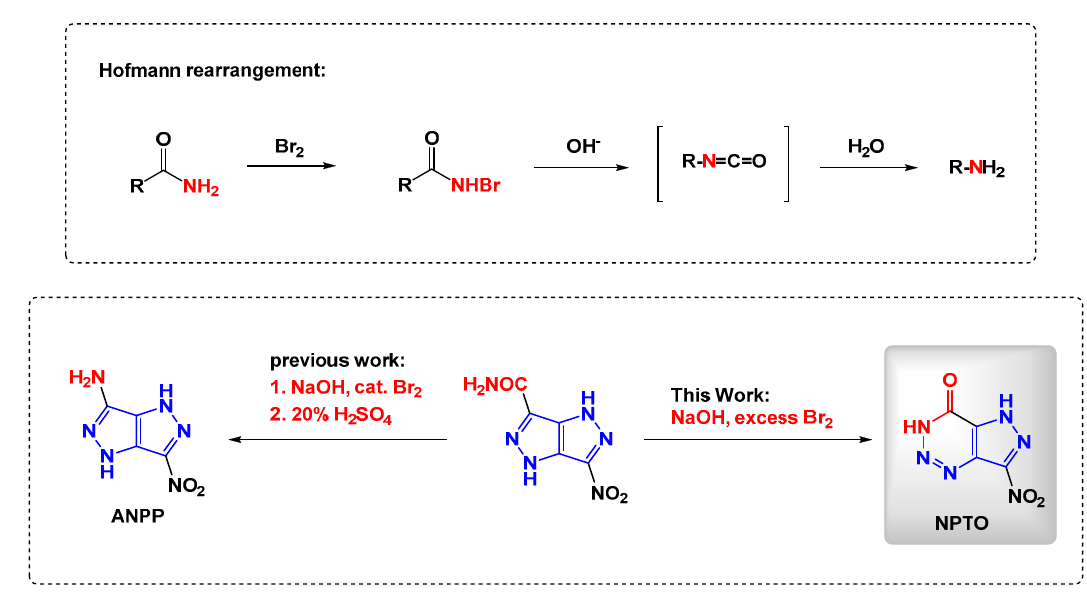
Figure 2. Hofmann rearrangement and the synthesis of NPTO.